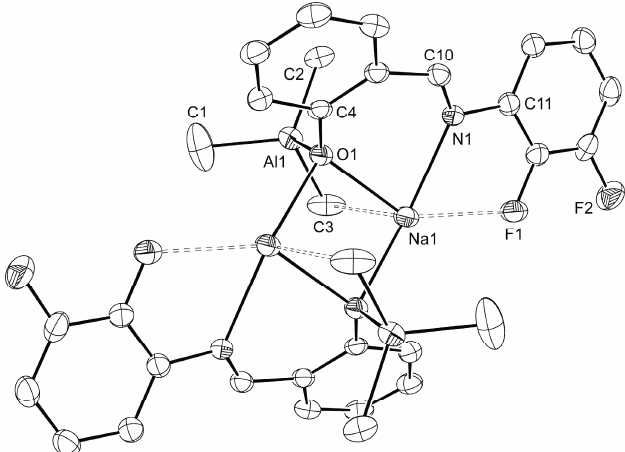
Figure 2. ORTEP plots for 2 showing thermal ellipsoids plots (30% probability). Hydrogen atoms are omitted for clarity. Selected bond distances (Å) and angles (deg.): C(3)-Al(1) 1.981(4), C(2)-Al(1) 1.965(3), C(1)-Al(1) 1.977(4), O(1)-Al(1) 1.8621(19), C(3)···Na(1) 2.737(6), C(10)-N(1) 1.275(3), Na(1)-